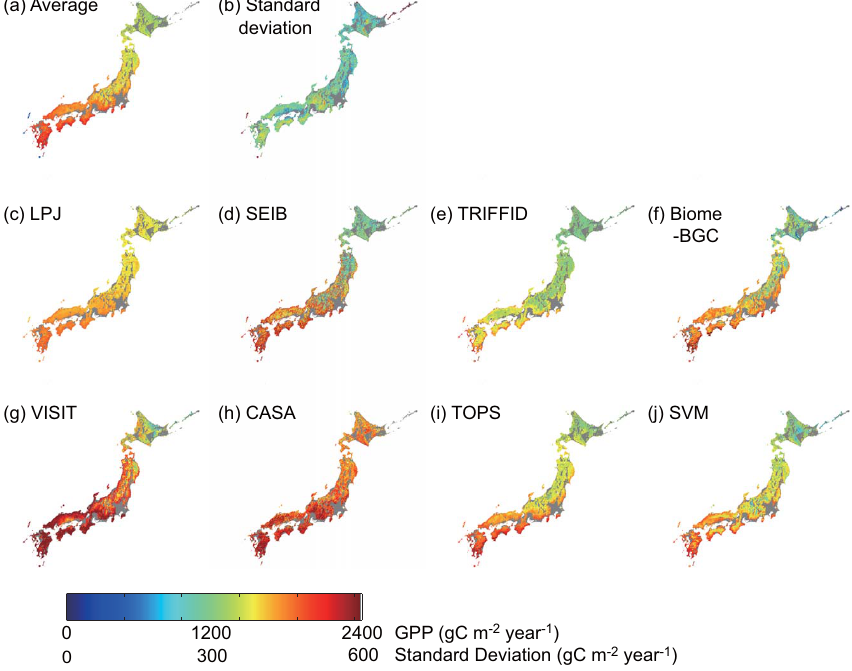
Fig. 8. Same as Fig. 7 but for the modified